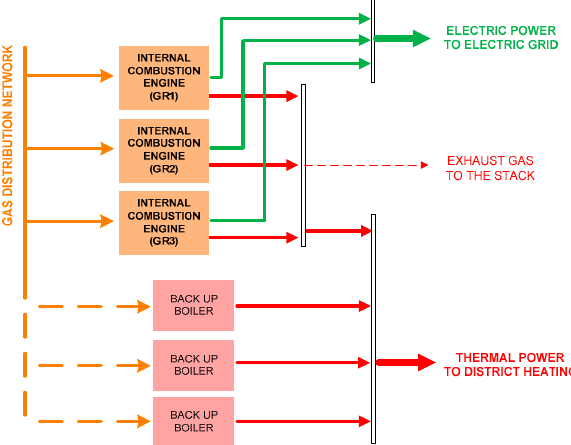
Figure 1. Schematic of the cogeneration power